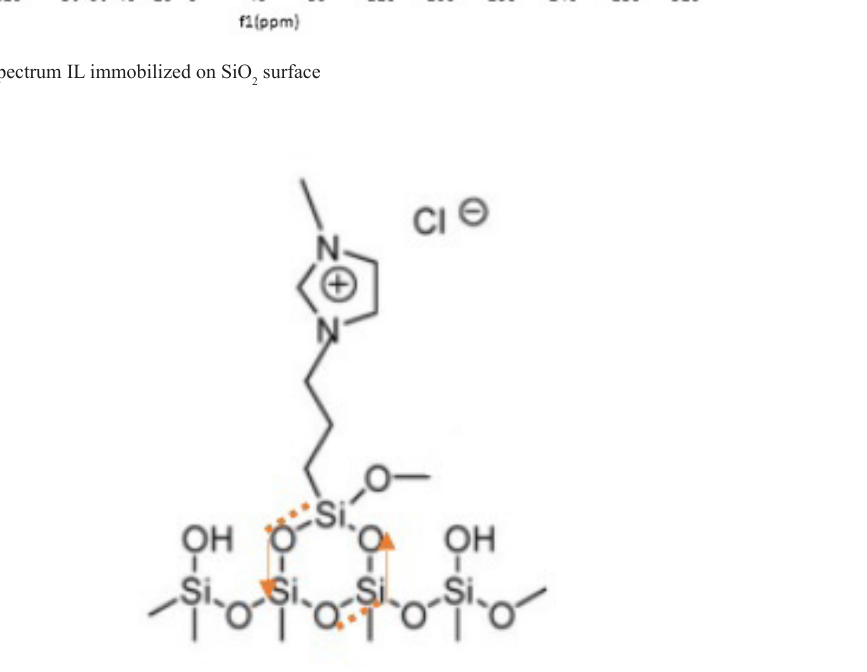
Figure 9. Proposed structure of the ionic liquid immobilized on SiO